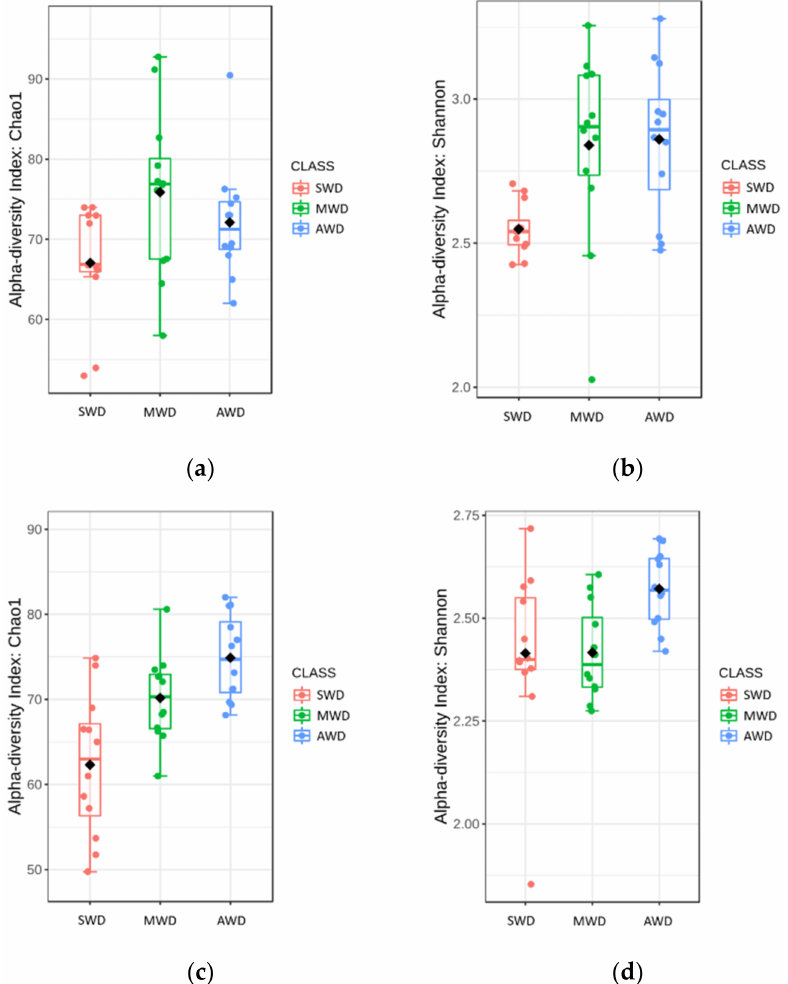
Figure 6. Boxplot illustrating the differences in ( a ) Chao1 and ( b ) Shannon diversity measures at 6-month sampling time and ( c ) Chao1 and ( d ) Shannon diversity measures at 12-month sampling time of the fungal communities in the bulk soil, at different irrigation regimes: severe water deficit (SWD), moderate water deficit (MWD), and absence of water deficit